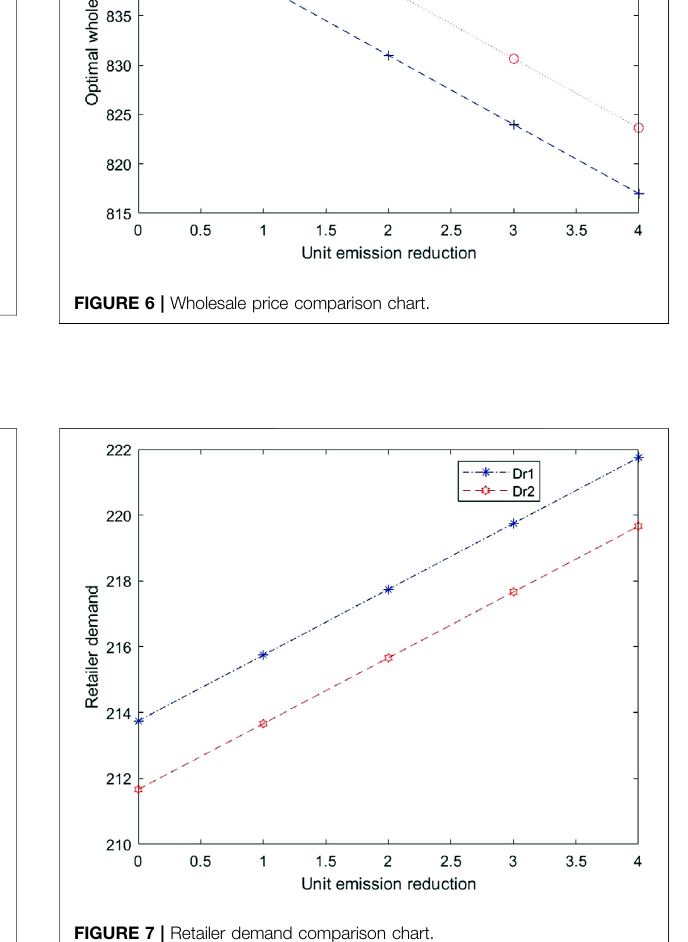
FIGURE 5 | Online price comparison chart.